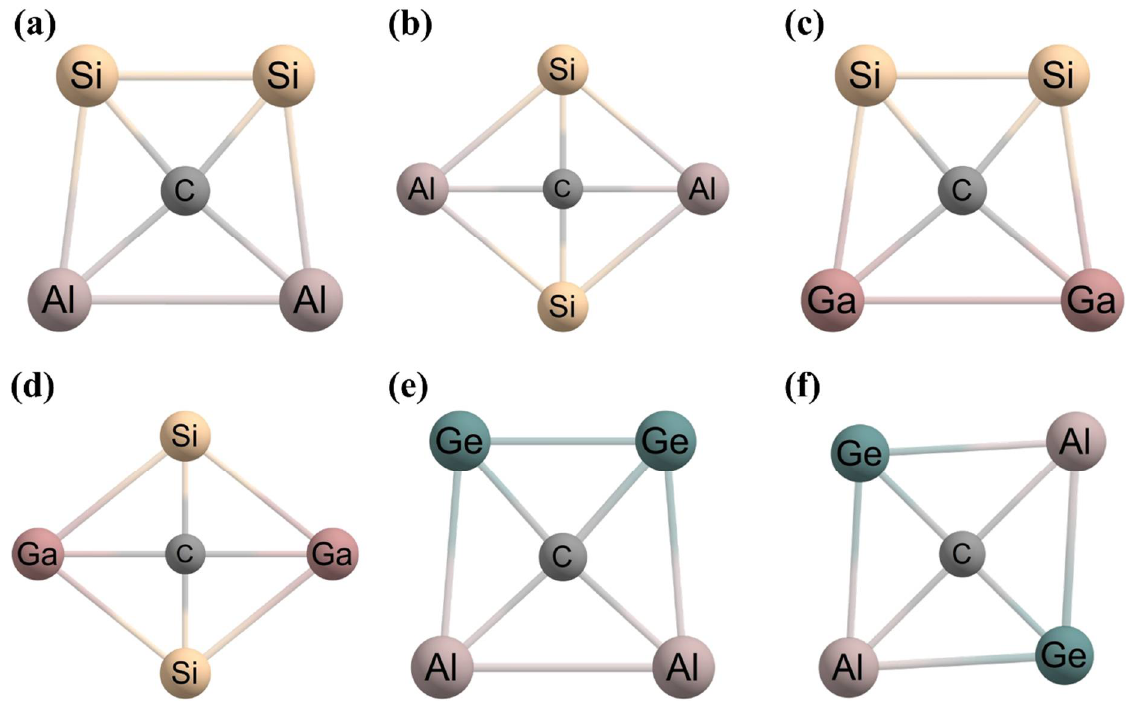
Figure 3. Optimized geometries of ( a ) cis -CSi 2 Al 2 , ( b ) trans -CSi 2 Al 2 , ( c ) cis -CSi 2 Ga 2 , ( d ) trans -CSi 2 Ga 2 , ( e ) cis -CGe 2 Al 2 , and ( f ) trans -CGe 2 Al 2 systems. Structure ( a ) has 1.16 kcal mol −1 lower energy than structure ( b ). Structure ( c ) has 2.01 kcal mol −1 higher energy than structure ( d ). Structure ( e ) has 2.87 kcal mol −1 lower energy than structure ( f ).